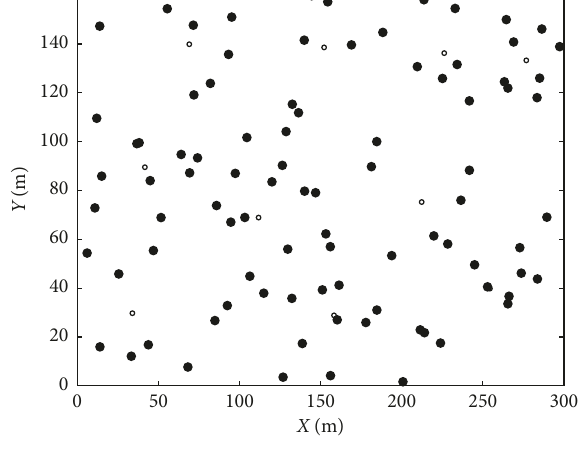
Figure 6: Node distribution.